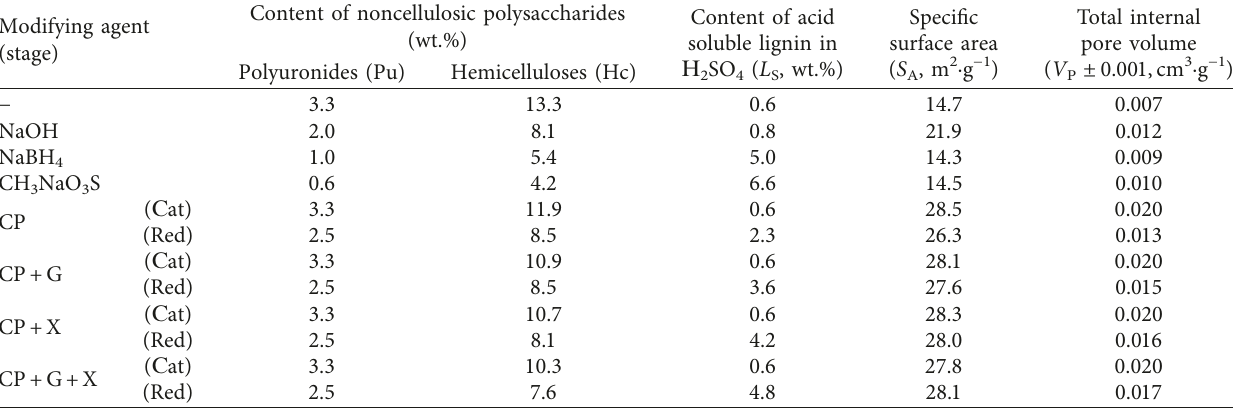
Table 2: Changes in the composition of not cellulosic polymeric components and in the pore structure of flax fibers after the chemical and biochemical modification. Content of noncellulosic polysaccharides Modifying agent (wt.%) (stage)